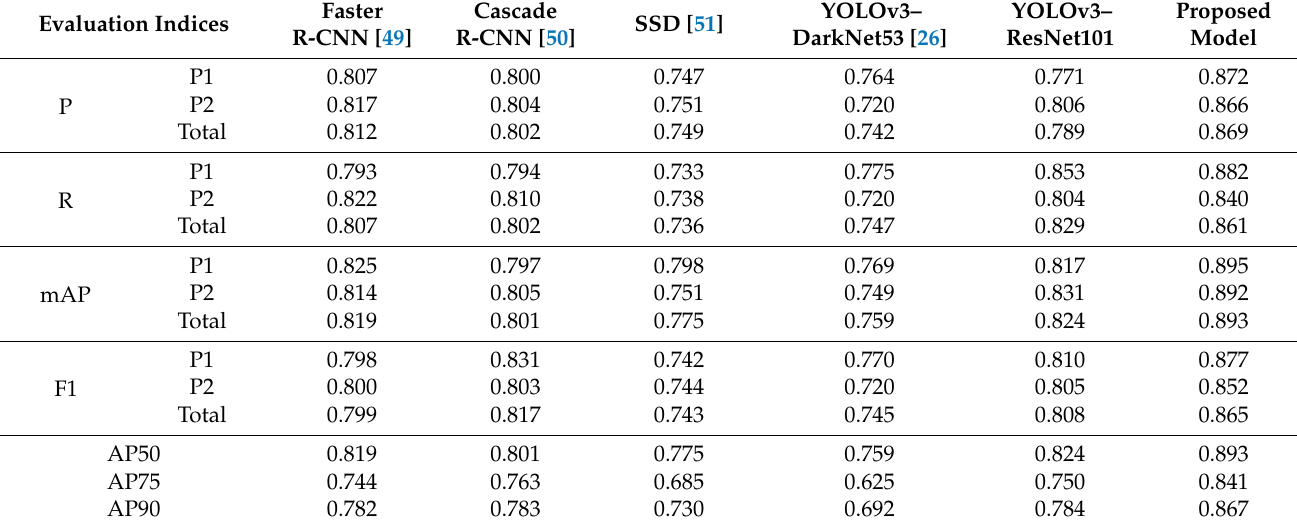
Table 8. Comparison of detection results of different object detection models for